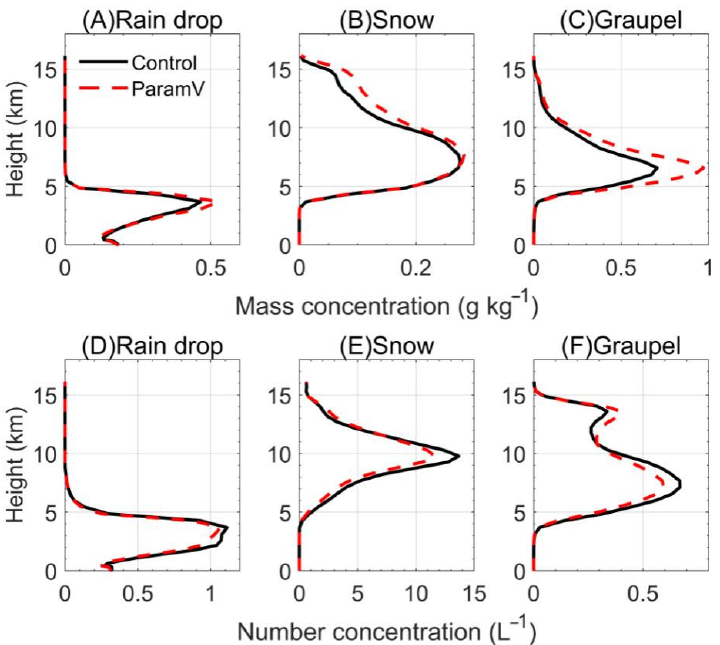
Figure 5. The vertical profiles of mass concentration ( A – C ) and number concentration ( D – F ) of the experiment with default parameterization of mean terminal velocity (Control, α = 1, black curve) and one with new parameterization (ParamV, red dashed curve): ( A , D ) raindrops, ( B , E ) snow, and ( C , F ) graupel.